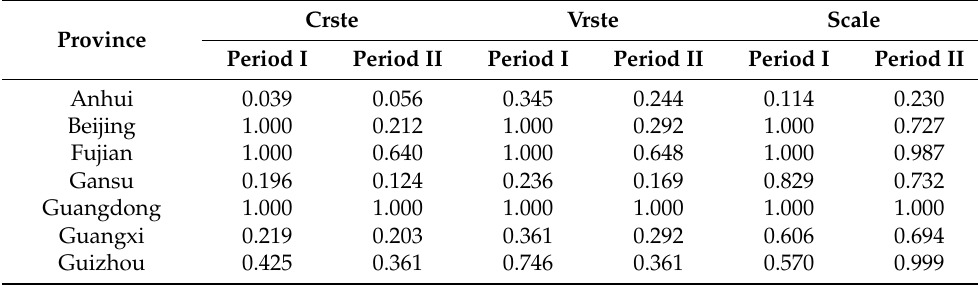
Table 6. Forest carbon sink efficiency of provinces in